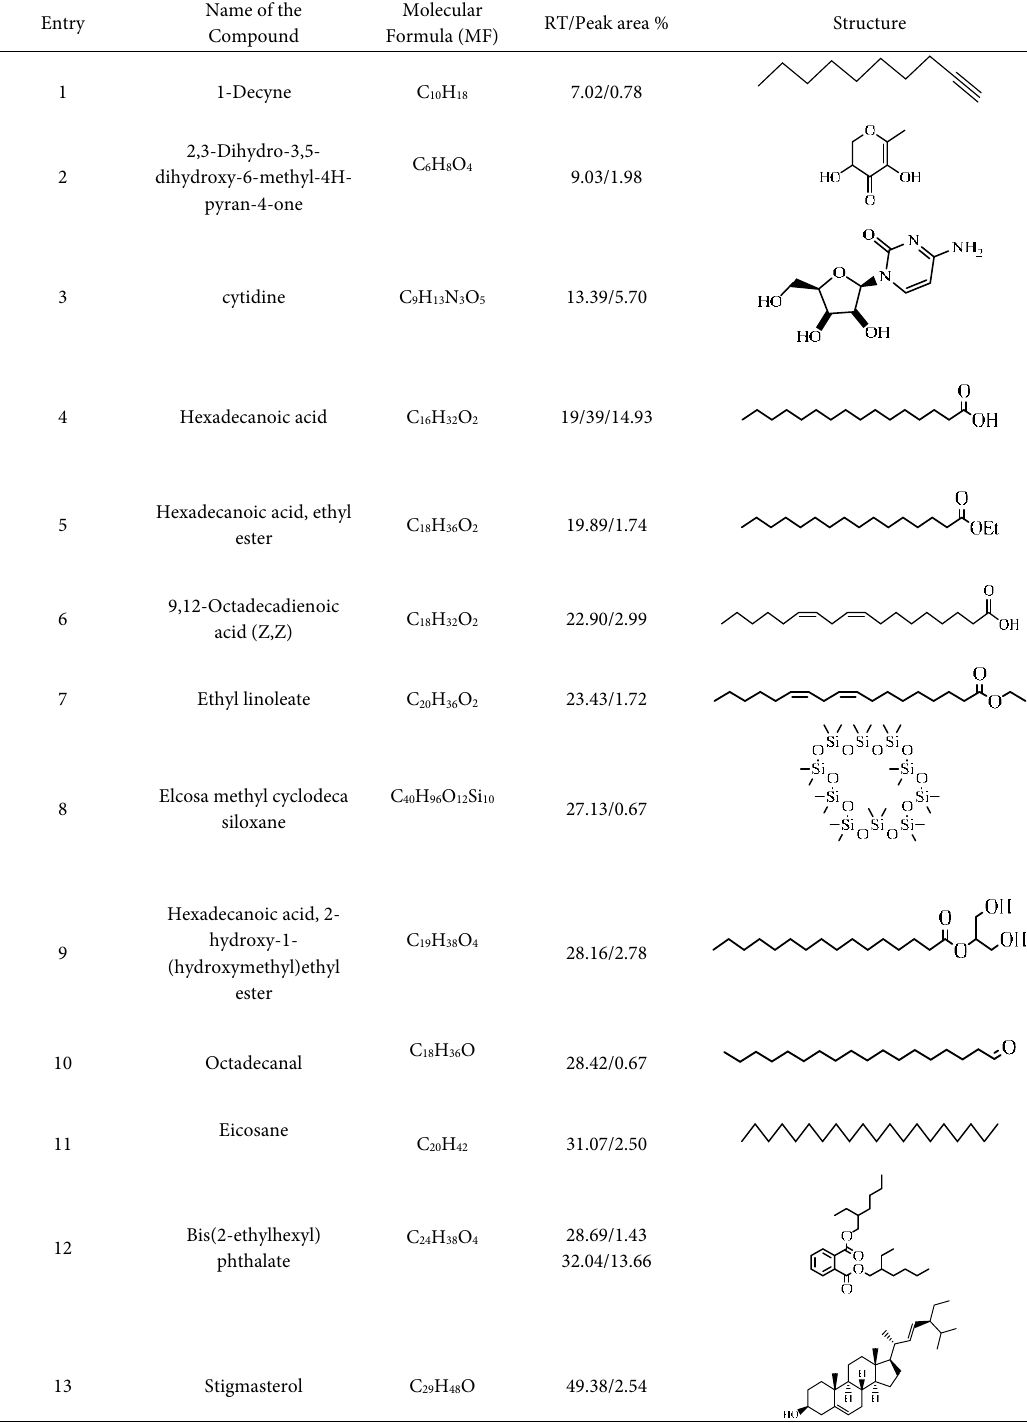
Table 1. Phytocomponents of purple Rose of Sharon flower extract by GC-MS